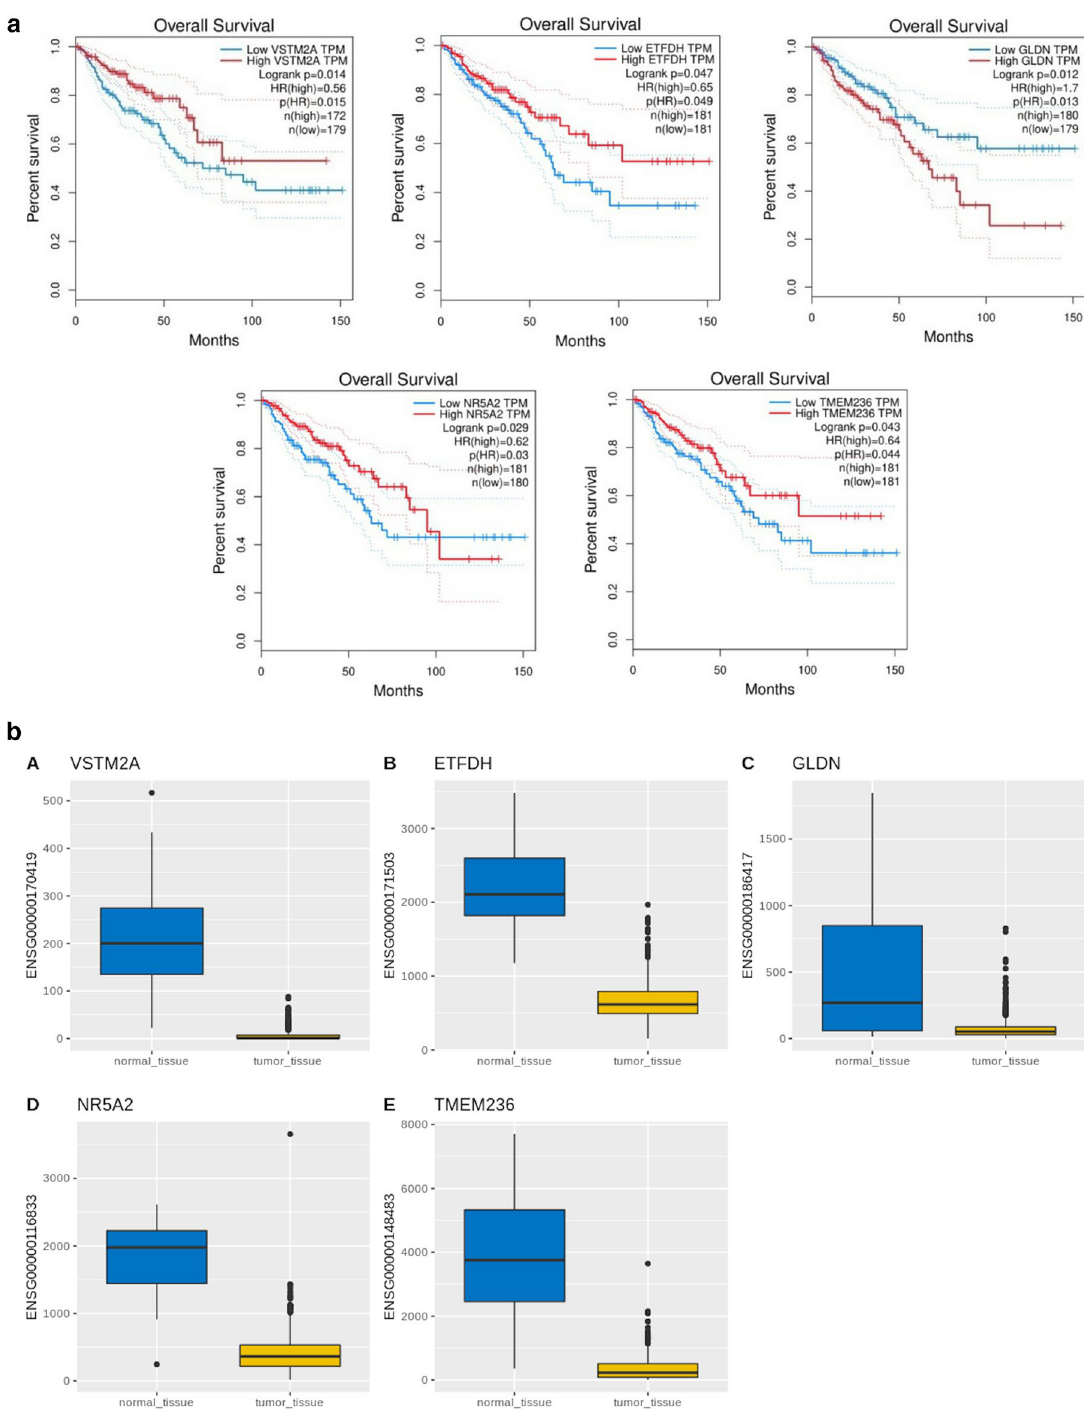
Figure 7. Survival and gene expression analysis. ( a ) Kaplan–Meier survival analysis of VSTM2A, ETFDH, GLDN, NR5A2, and TMEM236 for CRC dataset. ( b ) Gene expression of the VSTM2A, ETFDH, GLDN, NR5A2, and TMEM236 for CRC dataset from TCGA database. Blue: Normal tissue and Yellow: CRC tumor